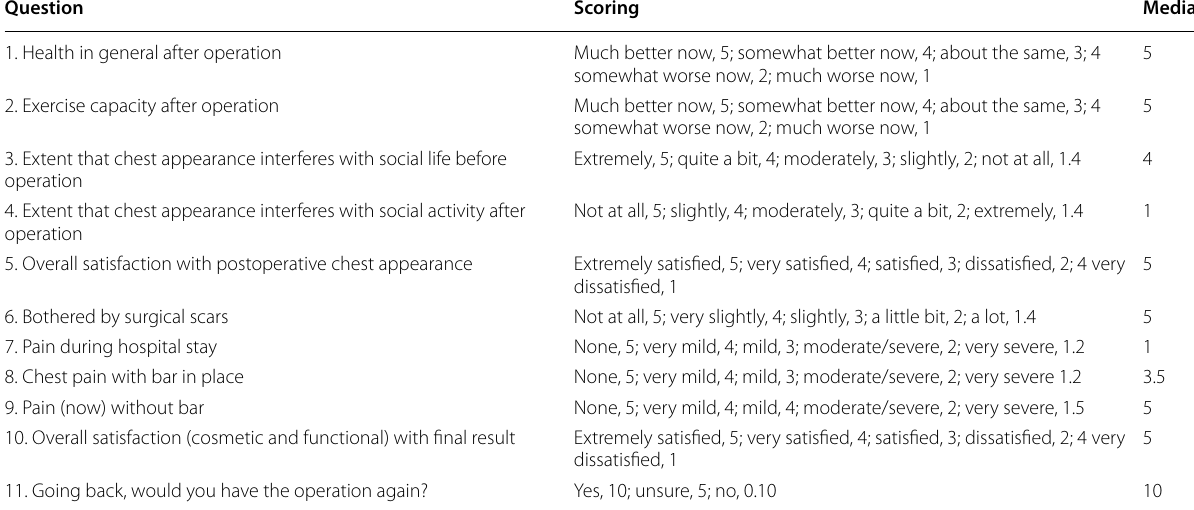
Table 1 Modified single-step questionnaire Question